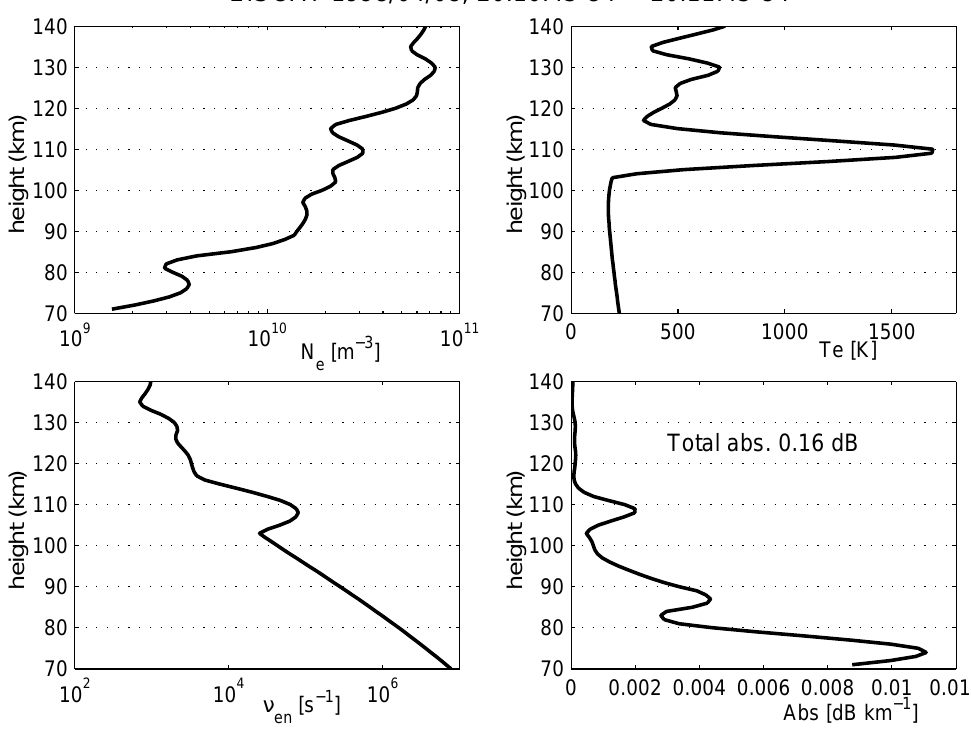
Fig. 7. Altitude profiles of electron density (top left), electron temperature (top right), electron-neutral collision frequency (bottom left) and incremental absorption for the 70 to 140km altitude at 19:46–19:47UT for Event 2. The strong enhancement in the T e , and its effect on the collision-frequency and absorption at about 110km altitude are clearly